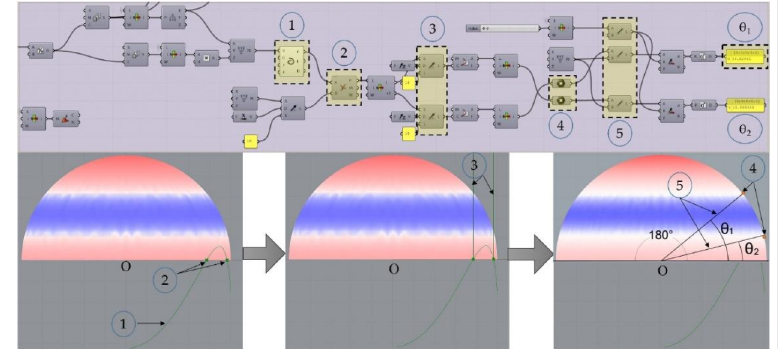
Figure 3. Position of neutral hoops on domes (sample: hemispherical dome with fixed